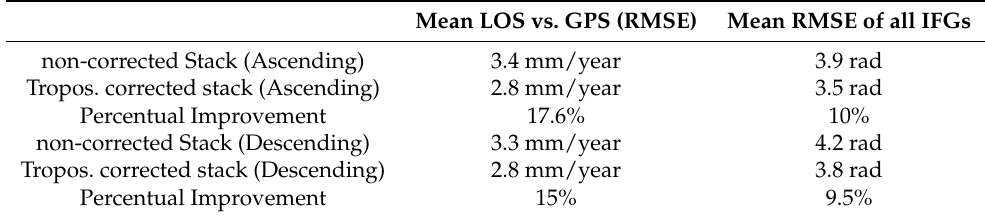
Table 1. Accuracy of DInSAR results before and after tropospherical correction. RMSE of GPS velocities projected into the LOS against the DInSAR results is given (middle column) as well as the mean RMSE for all interferograms used in the LOS velocity inversion (right